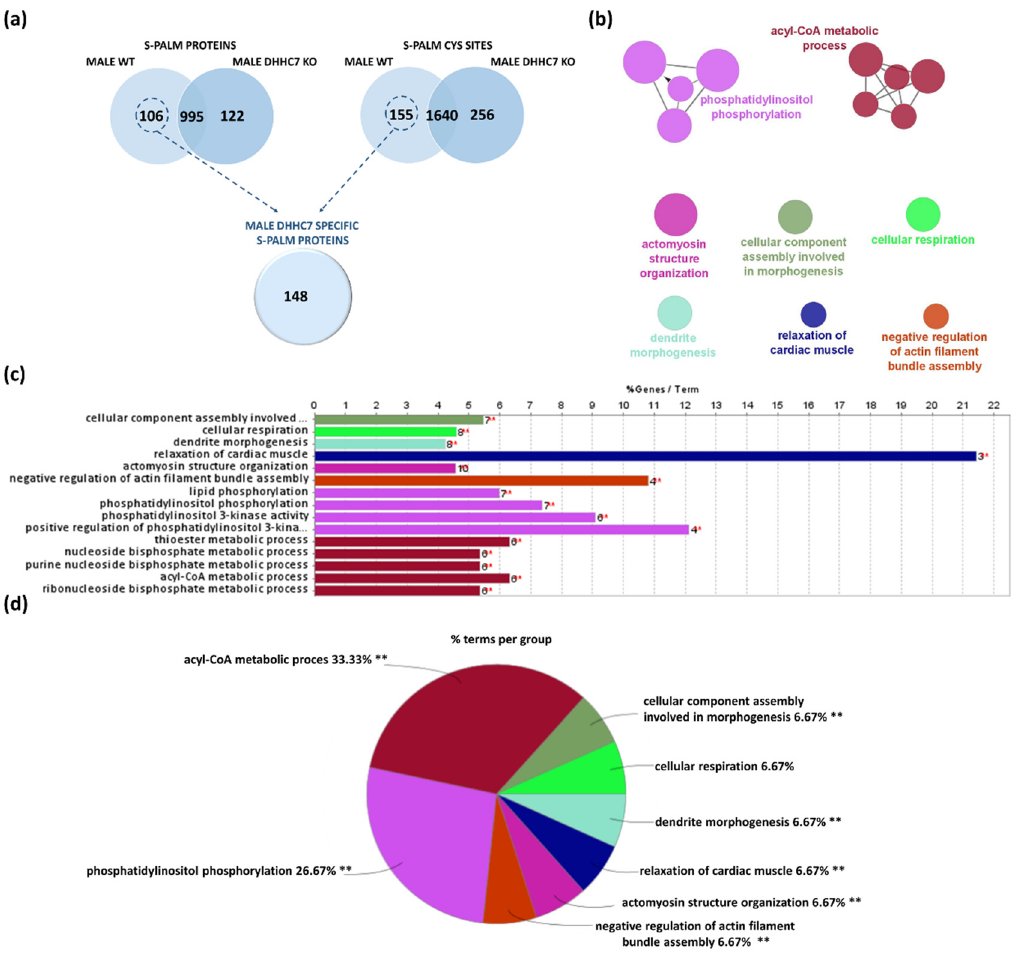
Figure 6. Analysis of male synaptic proteins regulated by DHHC7 using the Gene Ontology biological processes database and the Clue Go algorithm. ( a ) Venn diagram analysis of S-PALM in male WT and male DHHC7 KO synaptoneurosomes. ( b ) Network depicting interactions between enriched functional classes. ( c ) List of all enriched GO_BP functional classes ( p < 0.01) showed on the network. ( d ) Percentage of terms per group analysis of enriched protein classes. In order to decipher the molecular mechanisms at the synapse in which DHHC7-dependent S-PALM in males might play a distinct role, we performed func- tional enrichment analyses of terms from the GO_BP using the ClueGO algorithm.